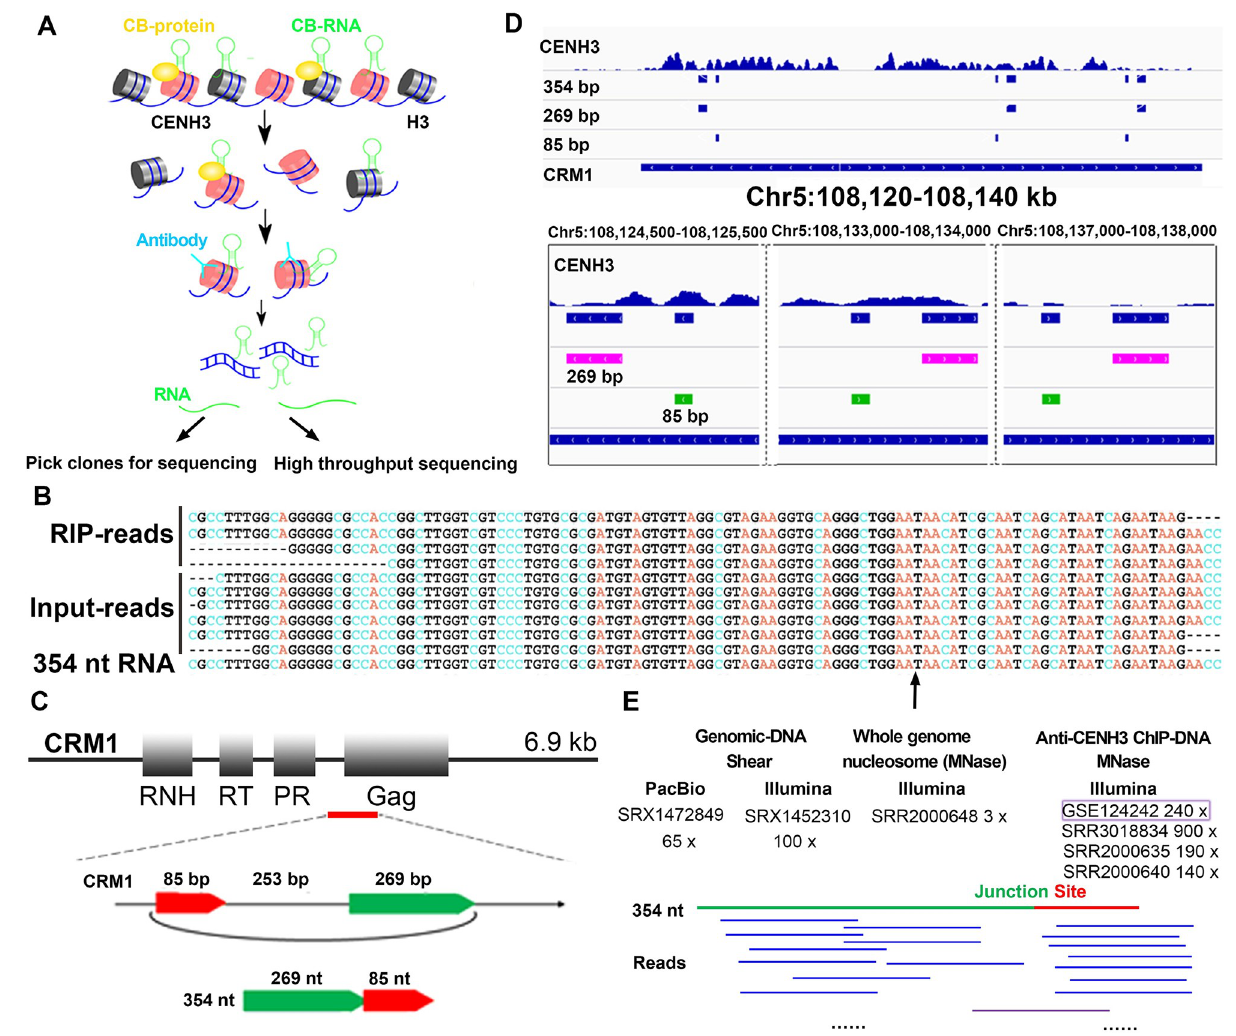
Fig 1. Back-spliced CRM1 RNA in the maize centromere. (A) Procedure for anti-CENH3 RIP and subsequent high-throughput sequencing and cDNA library screening. (B) BLAST results of the back-spliced CRM1 reads from the anti-CENH3 RIP-seq, input-seq data, and the 354-nt RNA from the anti-CENH3 RIP cDNA library. The arrow shows the back-splicing site. (C) The location of the 607-bp combined sequence in CRM1, and the back- spliced form of the 354-nt RNA. The red line represents the 607-bp sequence. (D) Distribution of the 354-bp sequence on CRM1. The first track of each panel represents the centromeric region indicated by CENH3 enrichment, and the peak height represents the RPM value (0–1). The other 4 tracks represent the distributions of the 354-bp, 269-bp, 85-bp, and CRM1 sequences along a specific region of cen5. The lower panel shows a detailed version of the information displayed in the upper panel. The arrows inside the rectangular bars represent the directions of the sequences. (E) The public raw genome sequencing data (including Pacbio [65 × ] and Illumina [100 × ] reads) and 4 anti-CENH3 ChIP-seq datasets from B73 (including 1 generated in this study and 3 from public resources), together with 1 input-seq dataset, were mapped to the assumed 354-bp DNA. Only one read from anti-CENH3 ChIP-seq dataset was matched to the region containing the back-spliced junction site (purple line). All the other reads show no covering the back- spliced junction site. The data underlying this figure can be found in the GEO with accession numbers GSE124242, SRR3018834, SRR2000635, SRR2000640, SRR2000648, SRX1472849, and SRX1452310 and on Github (https://github.com/sxx-ying/maize-centromere-circRNA). CB, chromatin binding; CENH3, centromeric H3 variant; ChIP-seq, chromatin immunoprecipitation following high-throughput sequencing; Chr, chromosome; CRM, centromeric retrotransposon; Gag, gag protein; GEO, Gene Expression Omnibus; input-seq, input sequencing; nt, nucleotides; PR, protease; RIP, RNA immunoprecipitation; RIP-seq, RIP sequencing; RNH, RNase H; RPM, reads per million; RT, reverse transcriptase.